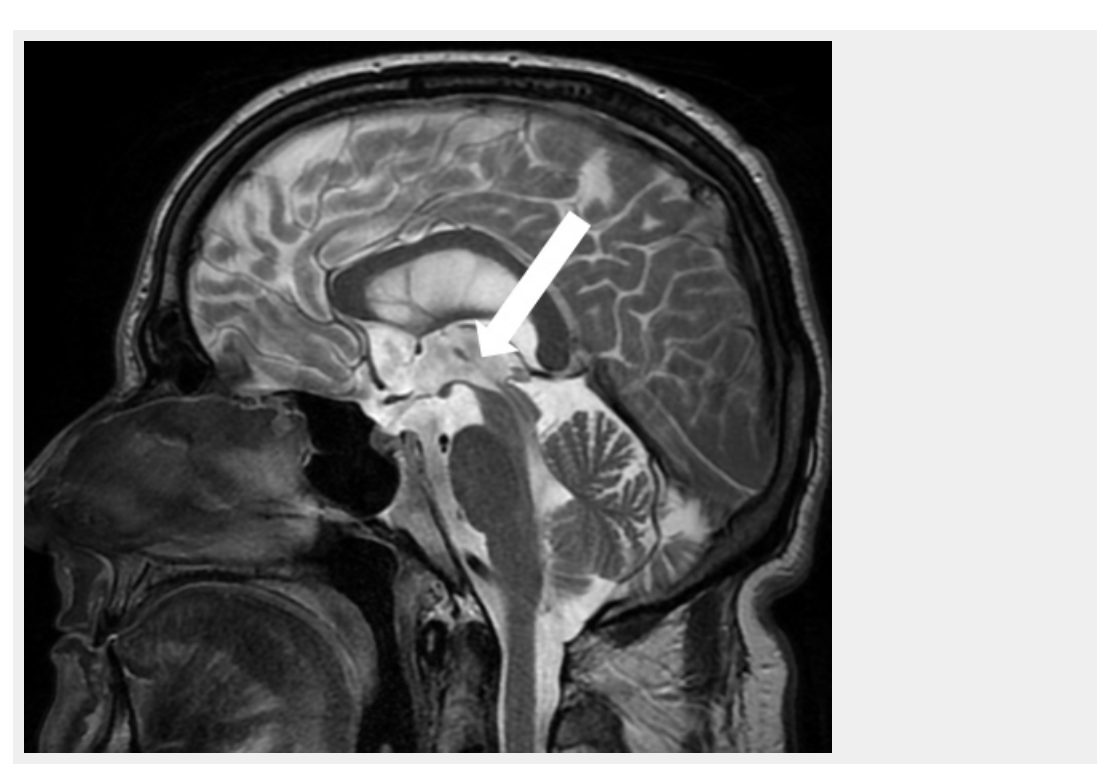
Figure 1 Brain MRI (T2) in sagittal plane of a patient with progressive supranuclear palsy (PSP). Note the marked midbrain atrophy adopting the appearance of a “hummingbird”